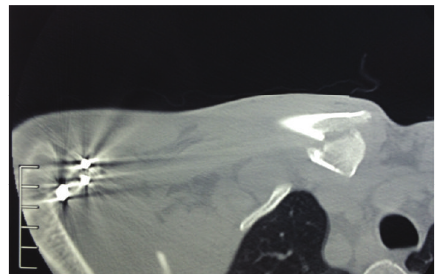
Figure 3: Medial clavicle fracture detected on CT